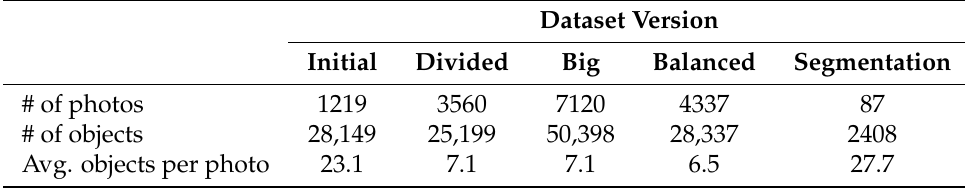
Table 2. Summary of created